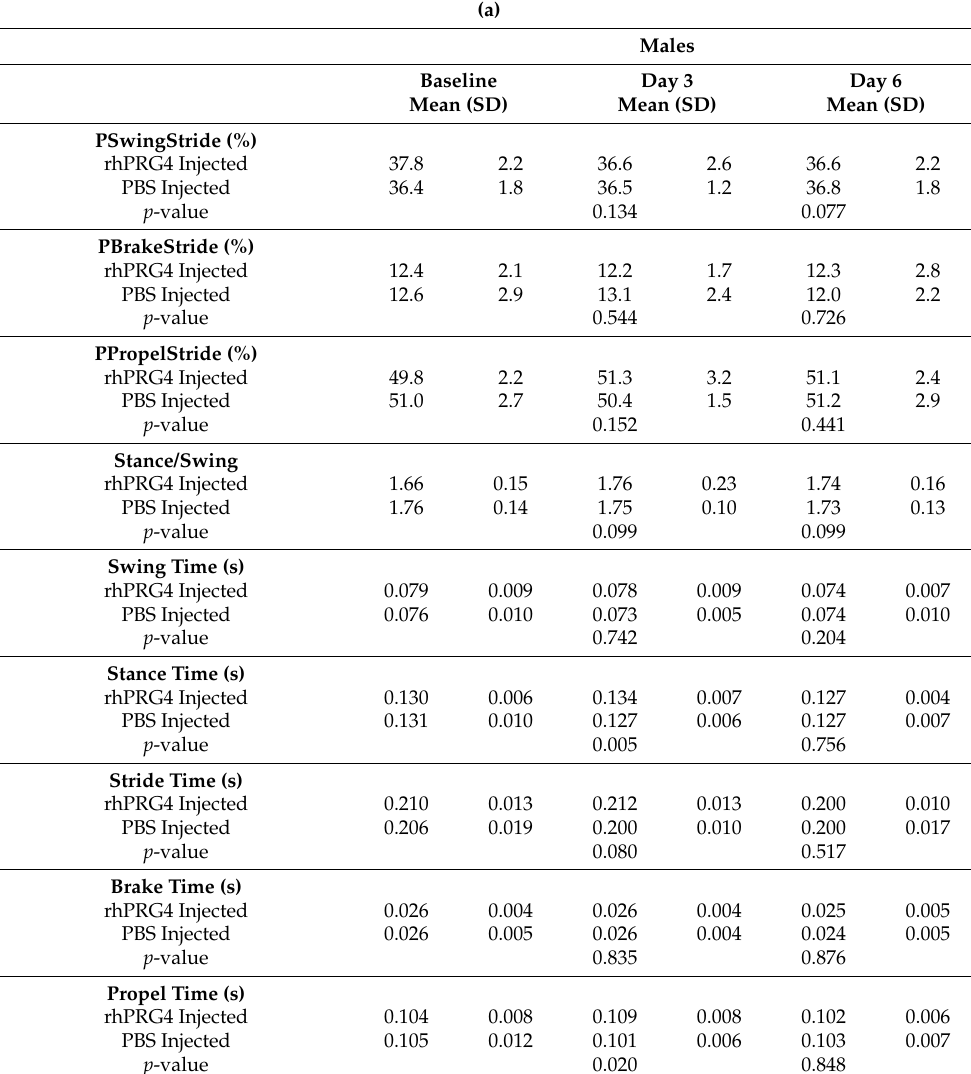
Table 2. (a). Male hindlimb gait data from baseline to 6 days post-injection. (b). Female hindlimb gait data from baseline to 6 days